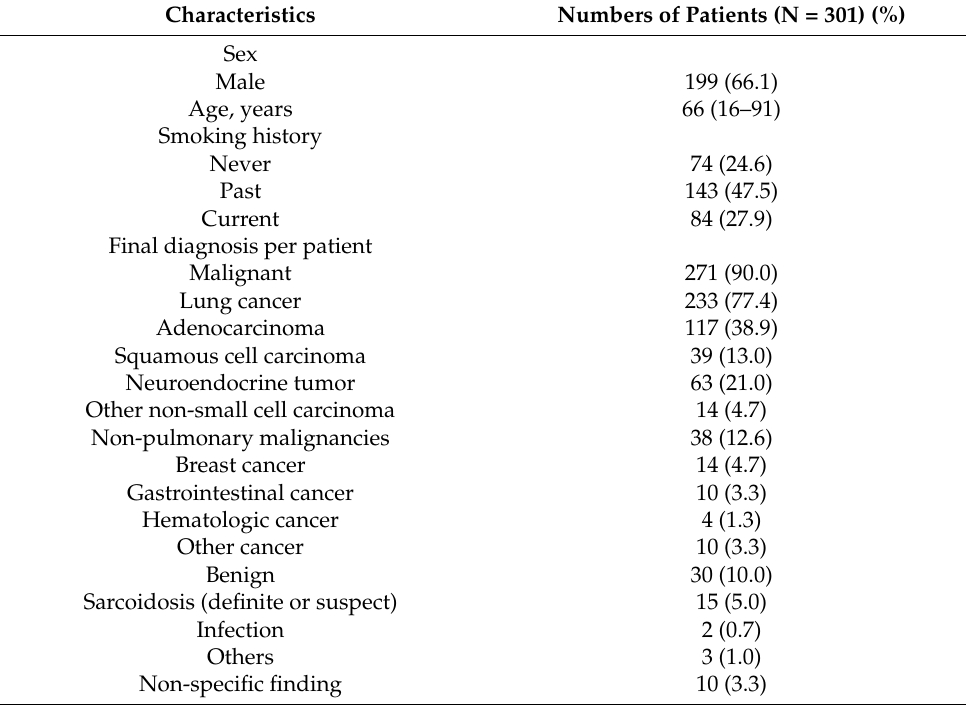
Table 1. Baseline characteristics of patients.